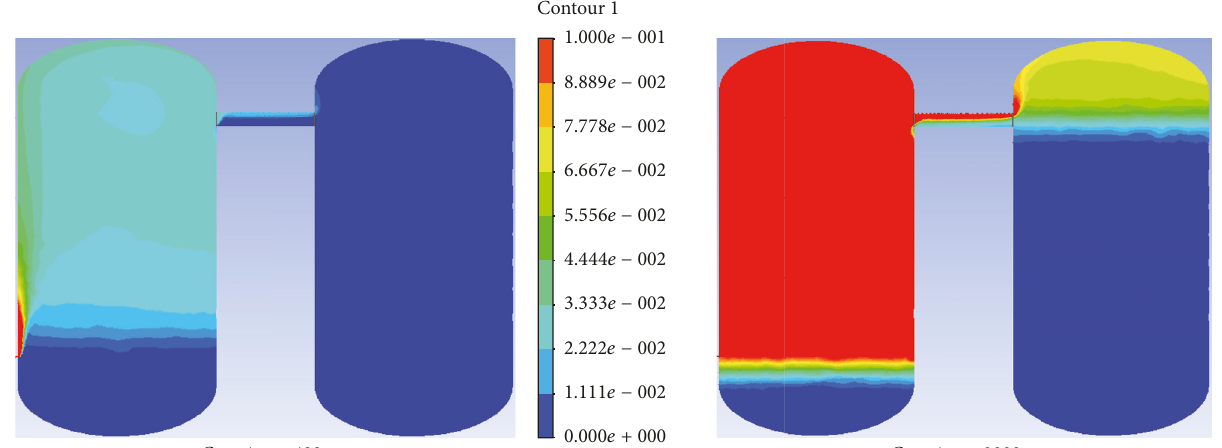
Figure 10: Hydrogen concentration in case 4